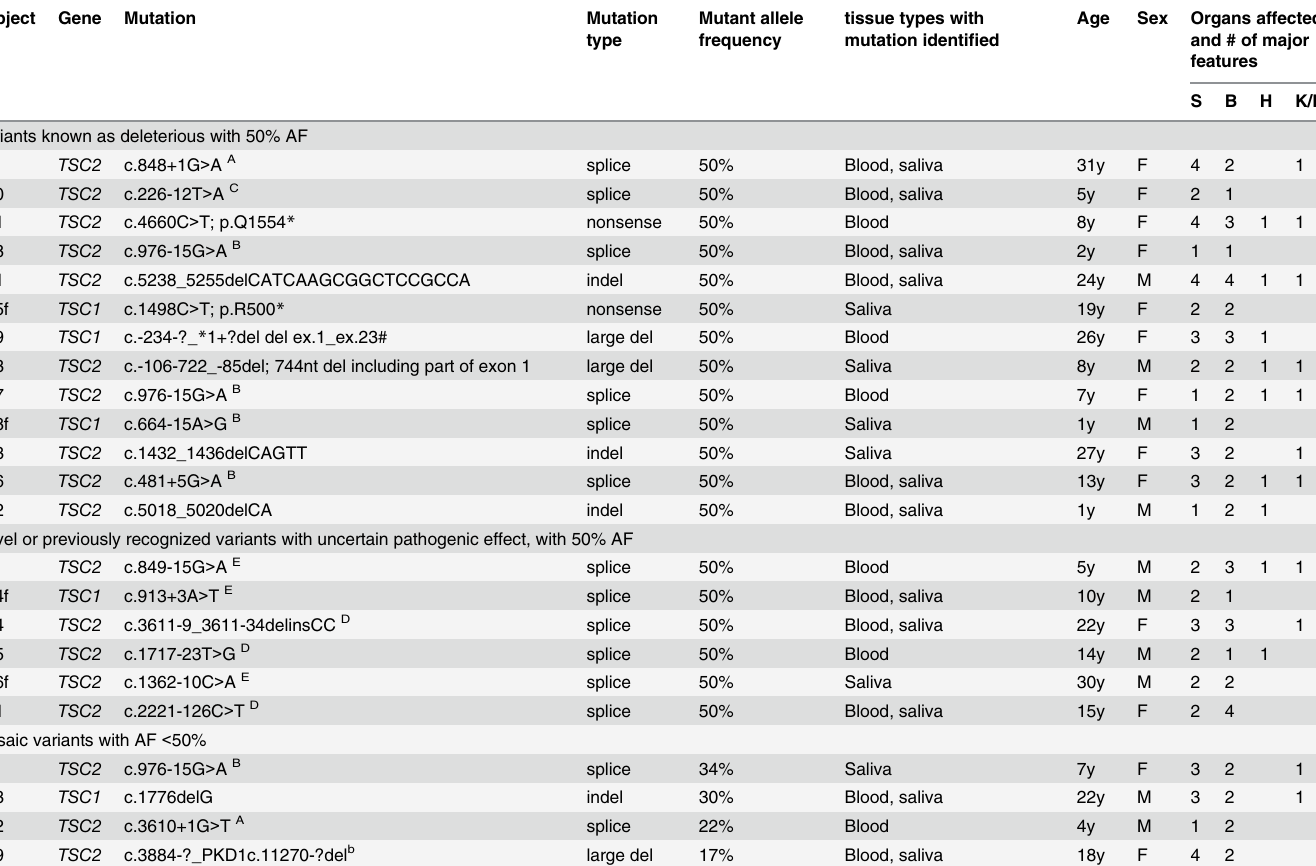
Table 1. Mutations identified in the TSC NMI